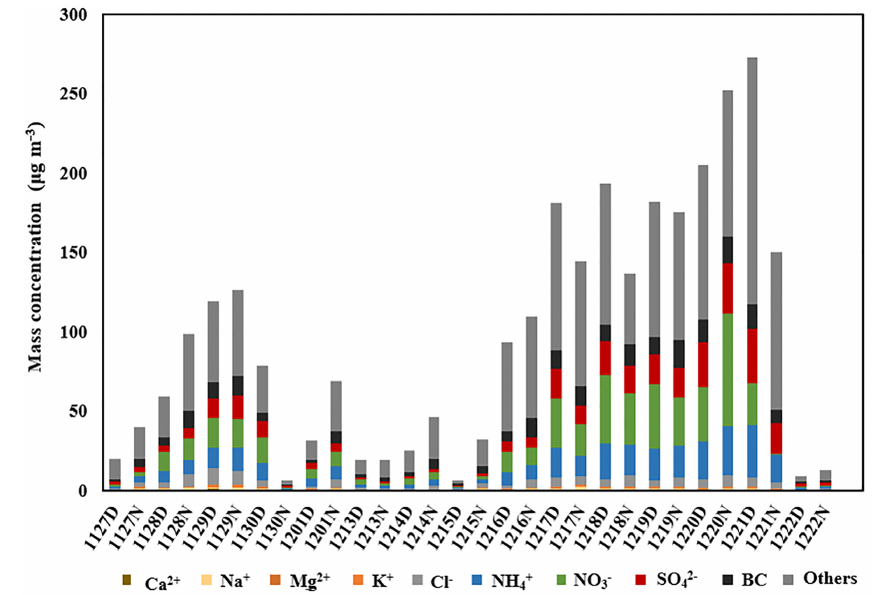
Figure 1. The time series of PM 2 . 5 concentrations and chemical composition. Data are shown for 15 different days; the dates are indicated in the x axis labeling and “D” and “N” stand for daytime and nighttime, respectively.